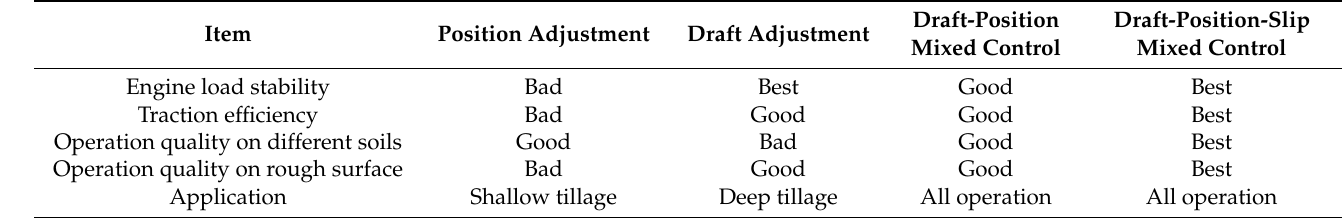
Table 3. Comparison of the different tillage depth adjustment